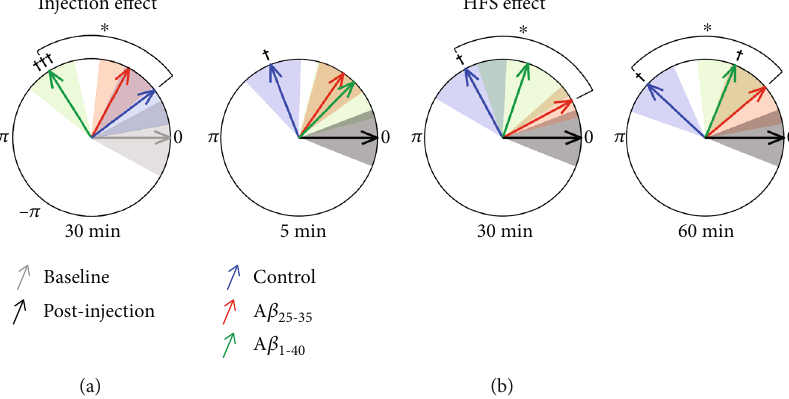
Figure 5: Peptide injection and HFS shifted the θ -to- γ PAC average phase vector. (a) Circular diagram illustrating the intrahippocampal microinjection-induced shift of the θ -to- γ PAC average phase vector for each group respecting the baseline vector. (b) Circular diagrams illustrating the time evolution (at 5, 30, and 60min) of HFS-induced shift of the θ -to- γ PAC average phase vector for each group respecting the microinjection vector. Coloured arrows indicate average vector angles (control, blue; A β 25-35, red; and A β 1-40, green); correspondingly coloured shaded areas illustrate the standard error of angles for each group. Signi fi cant di ff erences relative to the reference vector ( † p < 0 : 05 , ††† p < 0 : 001 ); signi fi cant di ff erences between groups ( ∗ p < 0 : 05